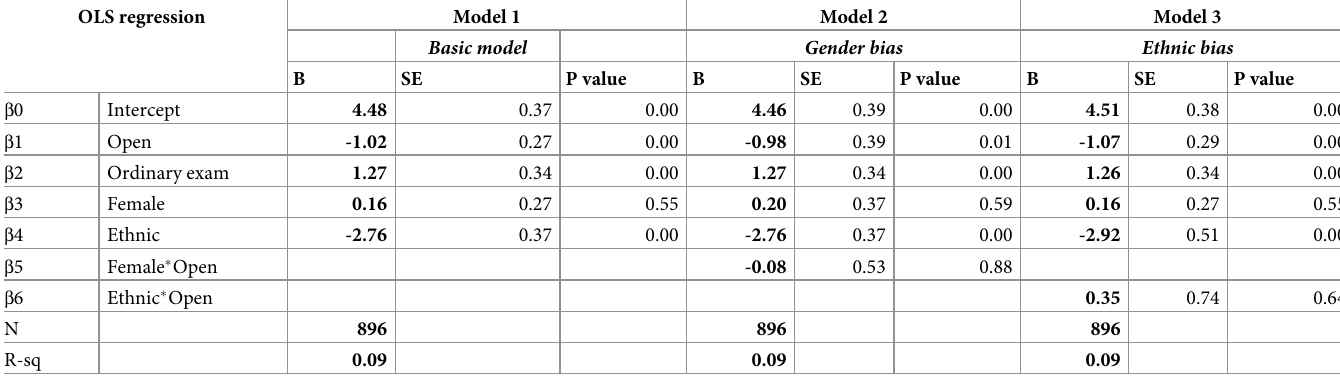
Table 2. Gender and ethnic based bias in grading. OLS